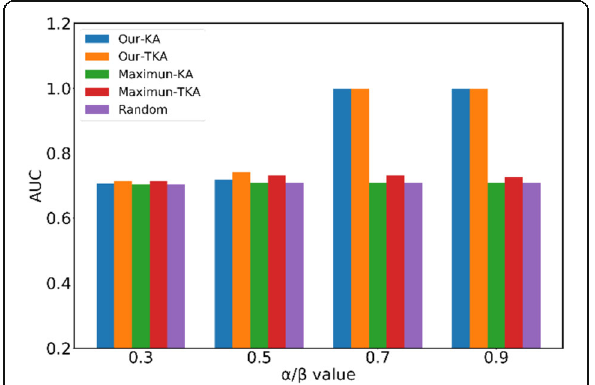
Fig. 7 The different parameters are employed in the weighted similarity function WJC and λ = 0.9 to obtain AUC values